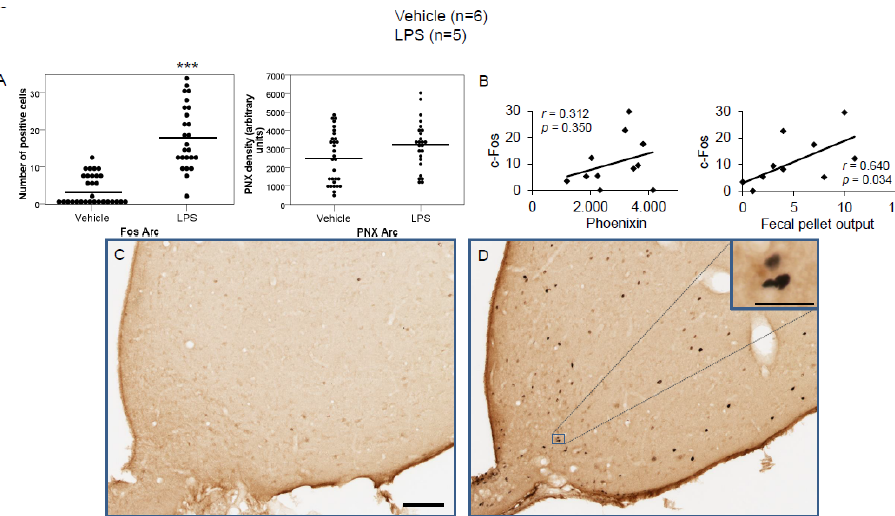
Figure 4. LPS stimulates c-Fos expression in the arcuate nucleus. Ad libitum-fed rats were subjected to IP injection of LPS or control, and 180 min after the injection, brains were processed for c-Fos and phoenixin double-immunohistochemistry. LPS stress significantly increased the number of c-Fos-positive cells but did not alter phoenixin density compared to controls ( A ). No significant correlation was observed between c-Fos and phoenixin immunoreactivity, while the number of c-Fos positively correlated with fecal pellet output ( B ). Representative pictures of the evaluated slides are shown in ( C ) (control) and ( D ) (LPS). The scale bar represents 100 μ m in the overview and 20 μ m in the insert. Data are expressed as individual data points (5/animal) and mean in ( A ). Mean values per animal are plotted in ( B ). *** p < 0.001. Abbreviations: 3V, third brain ventricle; Arc, arcuate nucleus.